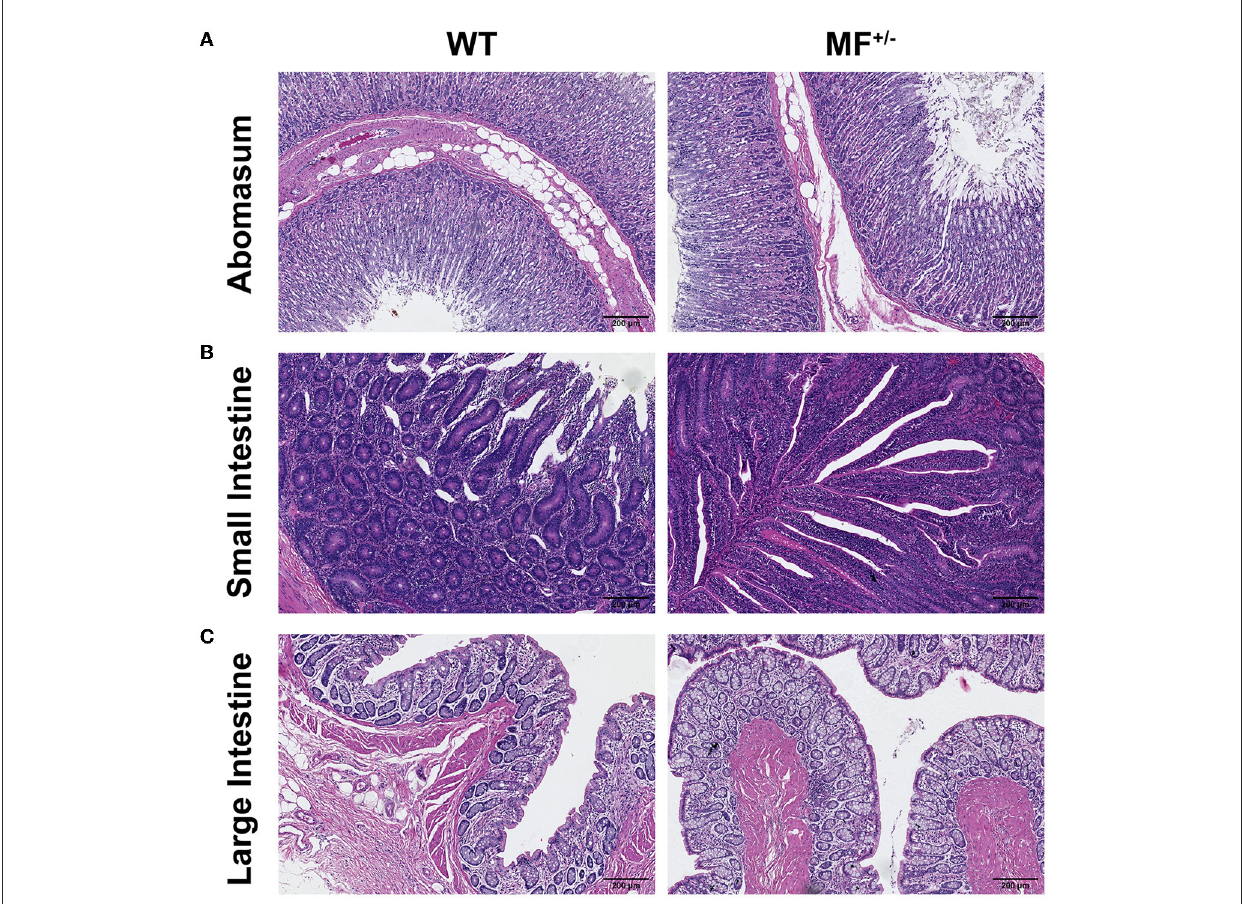
FIGURE5 Histological analysis of the digestive system in WT and MF + / − sheep. (A–C) HE staining of abomasum (A) , small intestine (B) , and large intestine (C) in 12-month-old WT and MF + / − sheep. Scale bar 200 µ m.